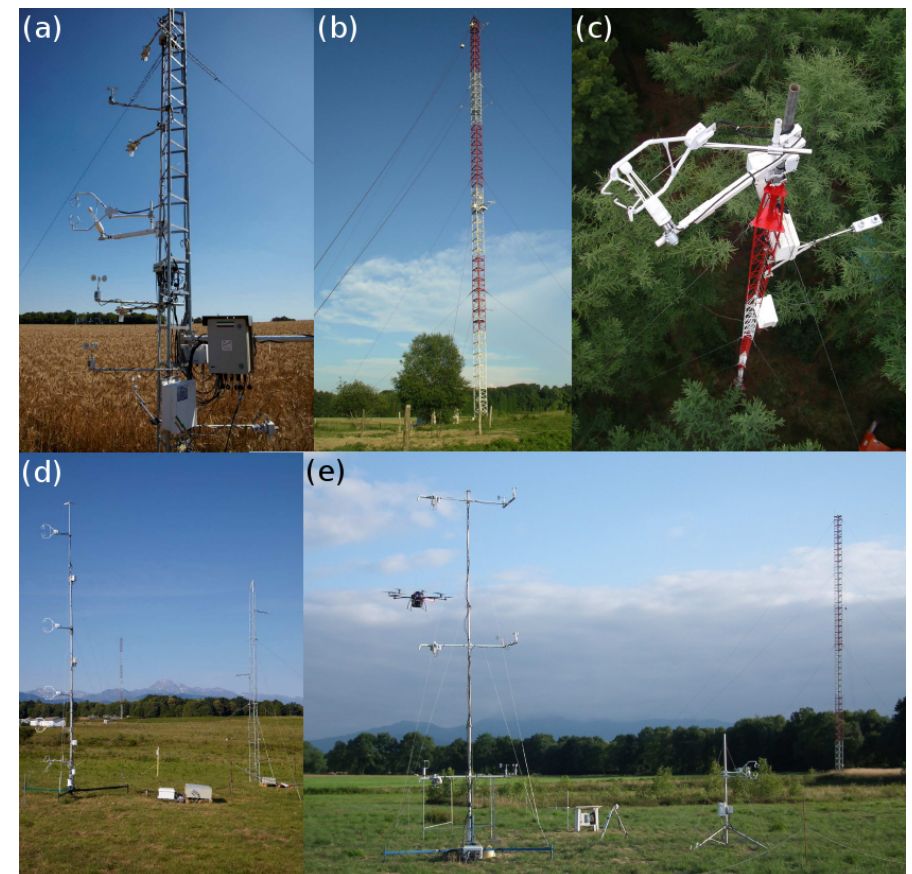
Figure 3. Examples of surface sites during BLLAST: (a) one of the towers at the ss1 over the wheat, (b) ss4 with the 60m tower, (c) ss5 over the forest, (d) ss2 over the prairies, and (e) ss3 over the micro-scale heterogeneous surface with the ss4 60m tower behind and the Octocopter flying around. Authors of the pictures: (a) , (d) Patrick Dumas; (b) , (c) Solène Derrien; (e) Daniel